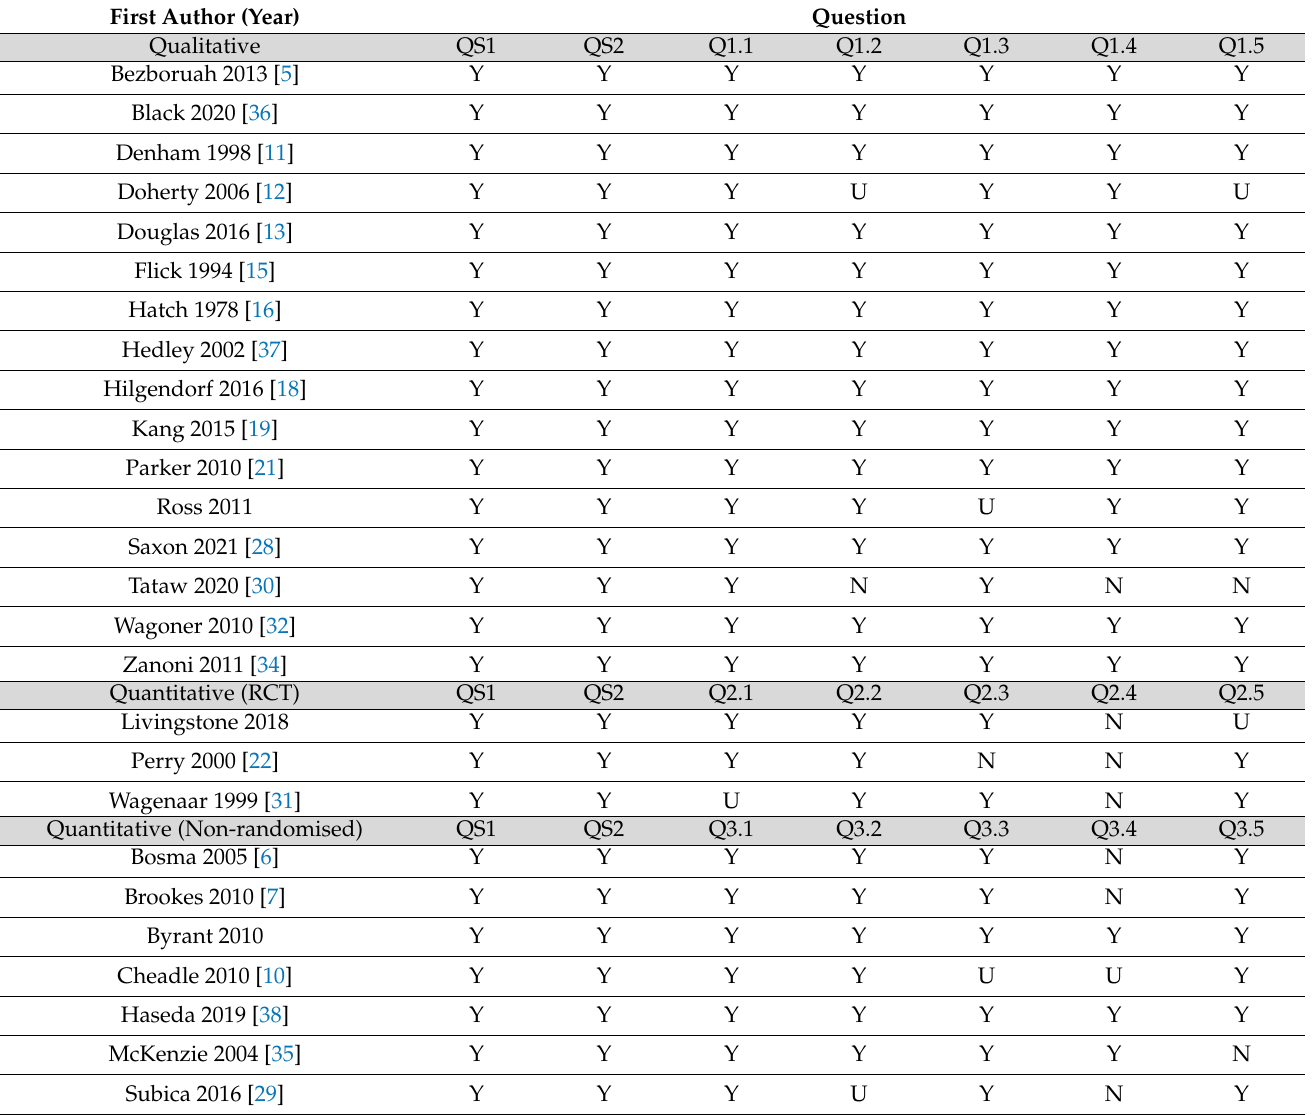
Table 3. Mixed Methods Appraisal Tool (Version 2018) for critically appraising quantitative (n = 14), qualitative (n = 16), and mixed methods (n = 2) study reviews.